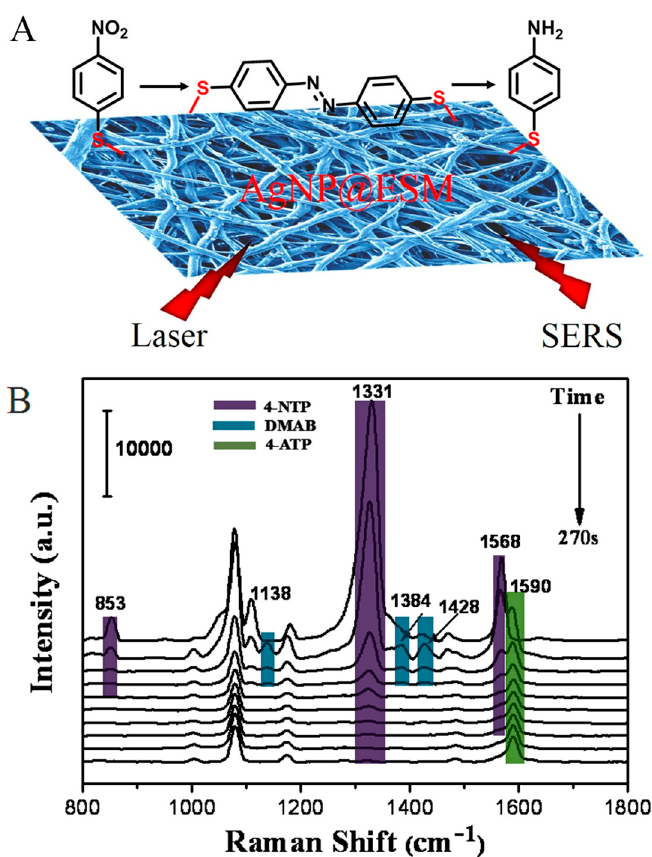
Figure 7. ( A ) Schematic illustration of 4-NTP conversion to 4-ATP on the AgNP@ESM surface and probing of the progress by SERS. ( B ) Time-dependent SERS spectra of 4-NTP conversion.